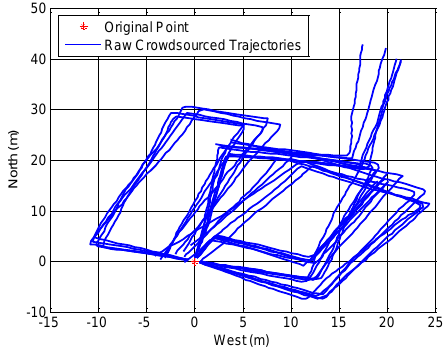
Figure 3. Description of Raw Crowdsourced Trajectories